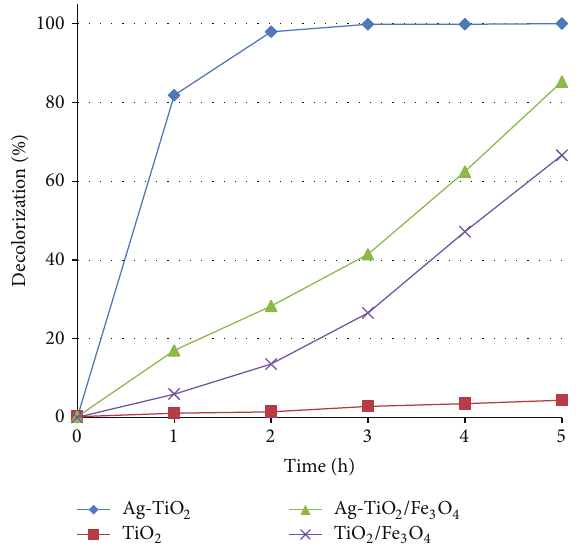
Figure9:Photocatalyticactivityindecolorizationofindigocarmine (O.D.620 = 0.1) under visible light irradiation at room temperature.